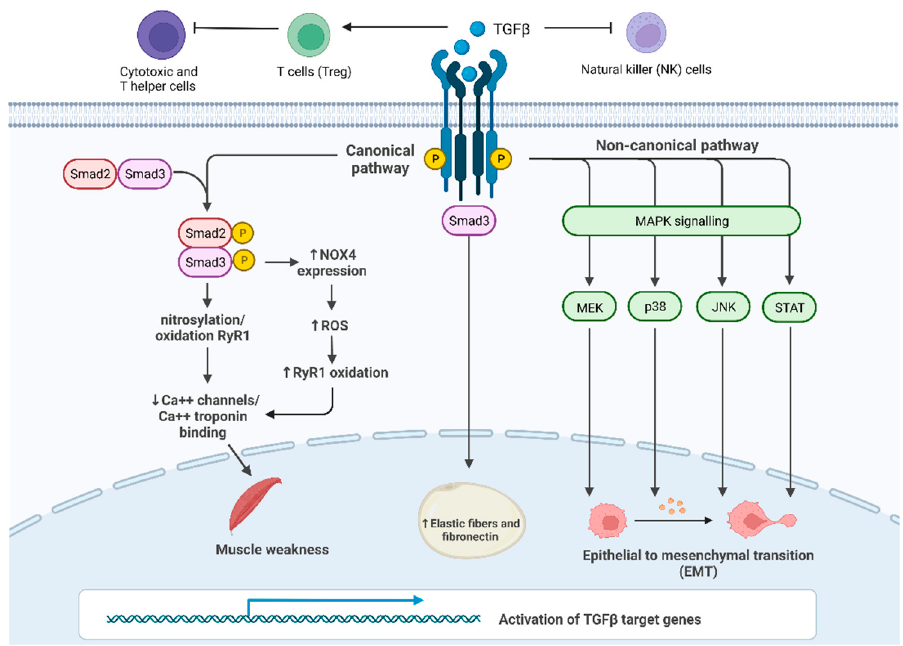
Figure 1. TGF- β signaling and its main roles in cancer progression and in cachexia: Canonical SMAD-dependent pathway: in proximal and distal skeletal muscles, SMAD3 signaling pathway results in the oxidation and nitrosylation of ryanodine receptor 1 (RyR1), which, in turn, reduces Ca 2+ channels in the sarcoplasmic reticulum and causes muscle weakness; furthermore, SMAD3 induces the transcription of Nox4 gene increasing the production of ROS that oxidize RyR1. Non-canonical JNK/p38 MAPK signaling pathway affects EMT in many tissues promoting cancer growth; c. TGF- β /SMAD3 pathway leads to an increase in fibrosis in the subcutaneous adipose tissue.